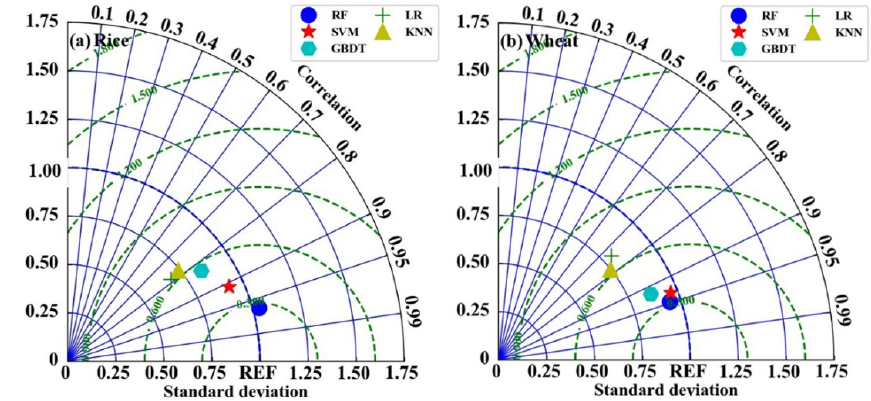
Figure 8. The performances of the five models for estimating H in the period of (a) rice and (b) wheat.